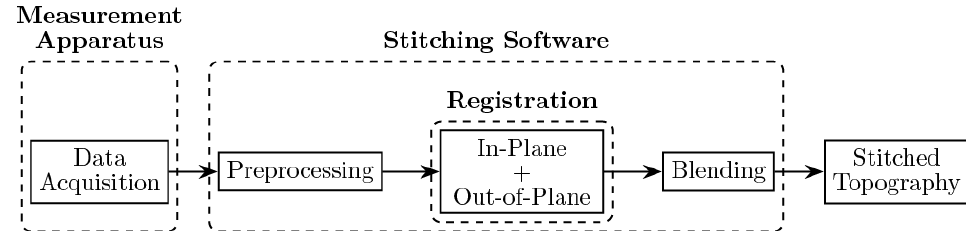
Figure 1. Generalized stitching procedure flowchart.